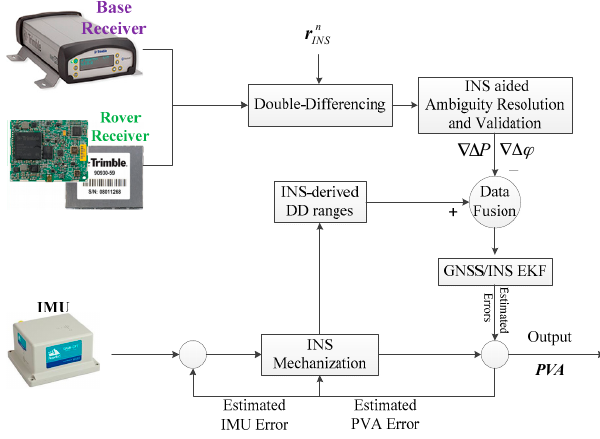
Figure 1. Architecture of the tightly-coupled integration of multi-GNSS SF-RTK/INS (Note: PVA represents the position, velocity and attitude information).